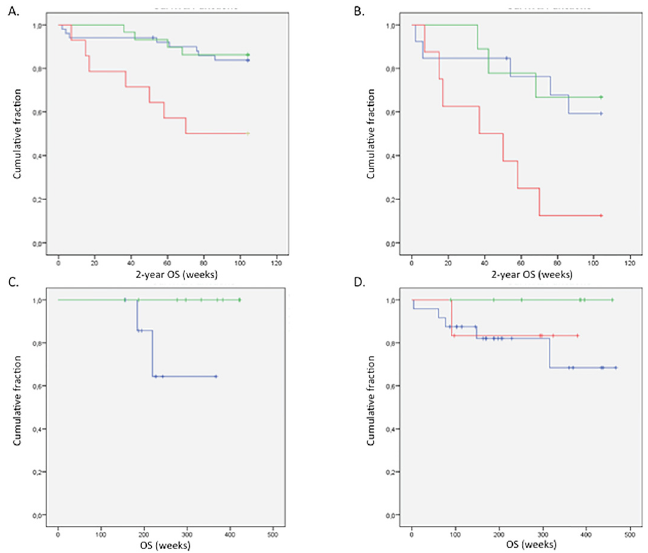
Fig 2. Kaplan Meier survival curves showing the number of CNAs and the overall survival. (A) For all stages, ** P = 0,004; (B) for stage IV, * P = 0,015; (C) for stage I, * P = 0,019 and (D) for stage II, * P = 0,019. In the survival curve three groups can be distinguished; the group with less than twelve alterations (blue), the group with twelve untill twenty alterations (green) and the group with more than twenty alterations (red).